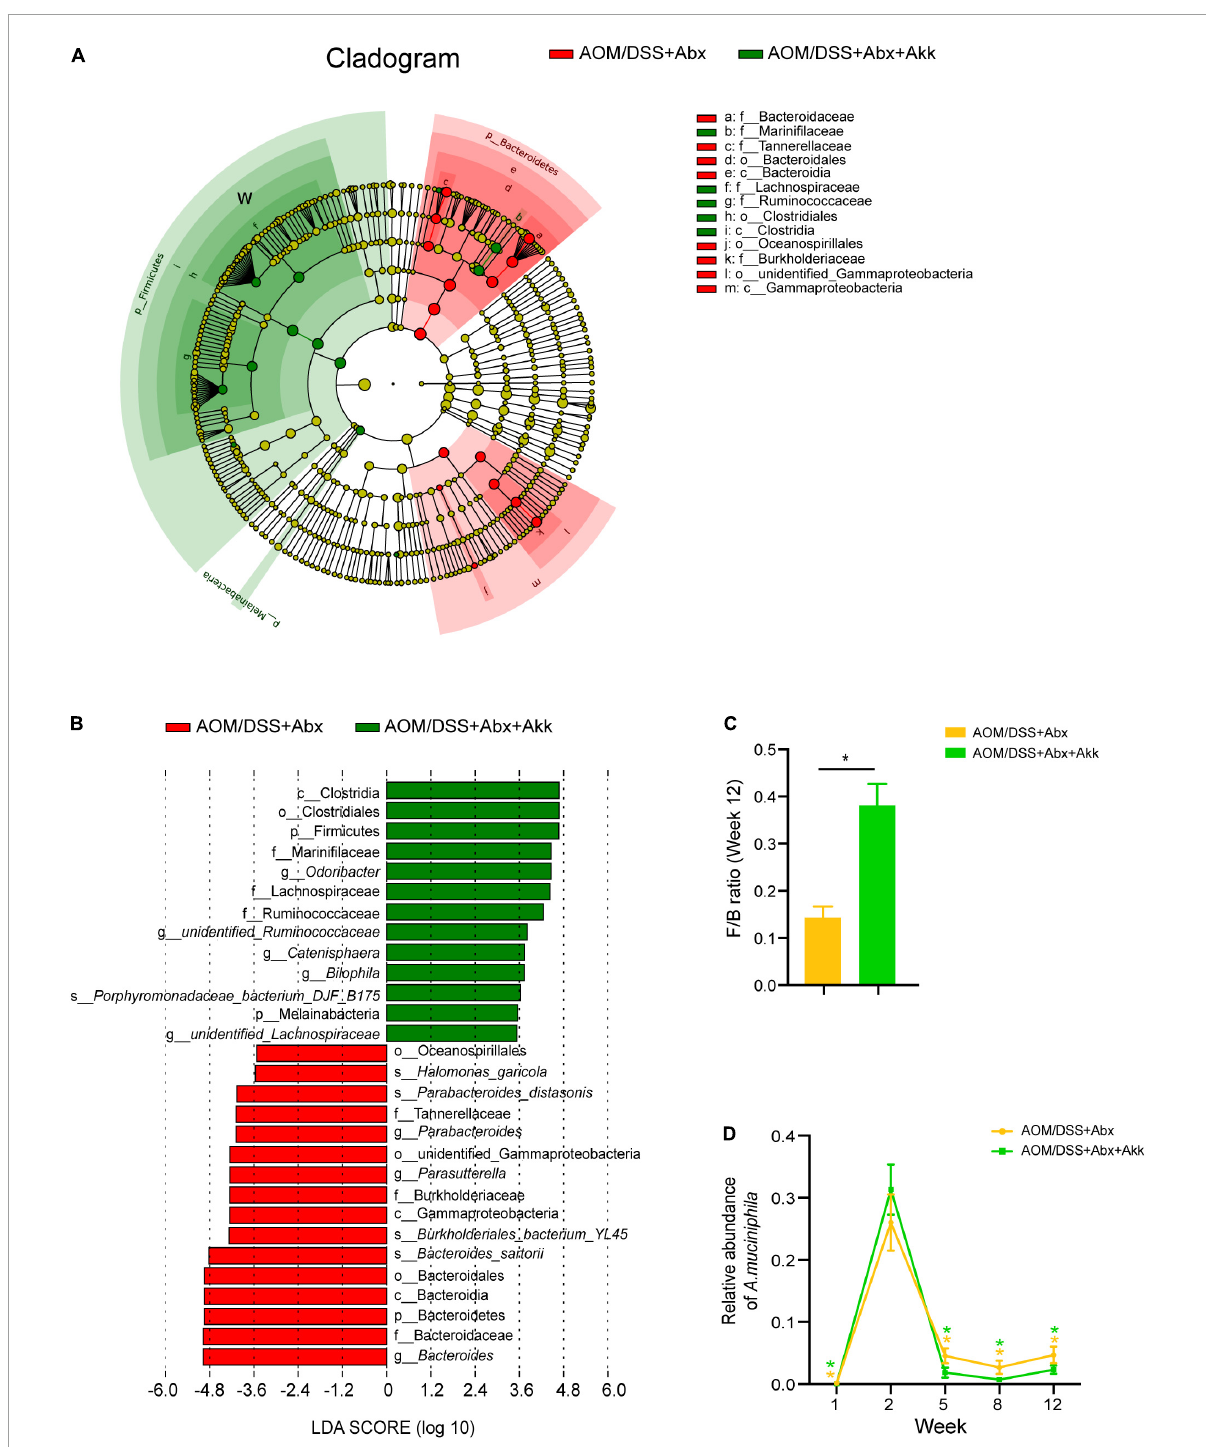
FIGURE6 Akkermansia muciniphila supplementation after antibiotic treatment shaped a distinct microbial profile at the end of the experiment (week 12). (A) LEfSe cladogram representing taxon enrichment in the AOM/DSS + Abx and AOM/DSS + Abx + Akk groups. (B) Discriminative microbial biomarkers with an LDA score of > 3.5 or < -3.5 in the AOM/DSS + Abx and AOM/DSS + Abx + Akk groups. (C) F/B ratio (week 12) in the AOM/DSS + Abx and AOM/DSS + Abx + Akk groups. (D) changes in the relative abundances of A. muciniphila in the AOM/DSS + Abx and AOM/DSS + Abx + Akk groups. Data are shown as means ± SEM. * P < 0.05. The asterisks on the line graph in panel D represent the results of comparing the A. muciniphila abundance of each group at each time point with the corresponding abundance on week 2. Colors of the asterisks represent different groups (yellow: AOM/DSS + Abx and green: AOM/DSS + Abx +